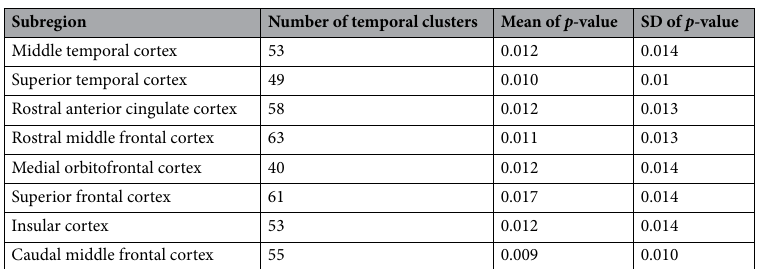
Table 3. Statistics of significant temporal clusters in the comparison between iEEG windows sampled around phrase boundaries and iEEG windows sampled around note onsets within each subregion in all twelve